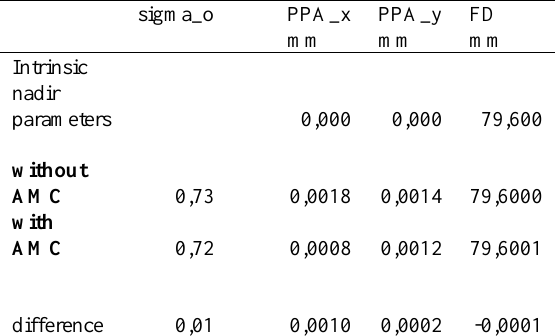
Table 1: Result of the flight mission without AMC and with